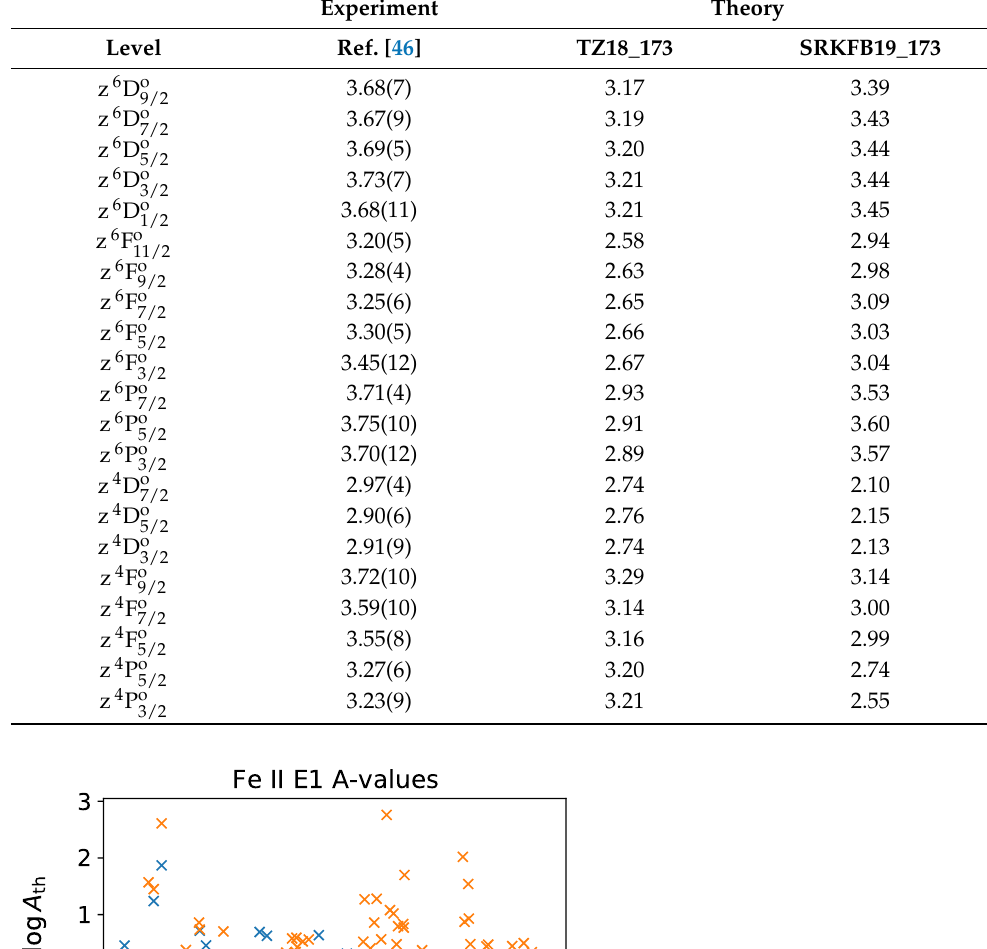
Table 14. Comparison of experimental lifetimes (in ns) of the 3d 6 ( 5 D ) 4p levels of Fe II with those derived from A -values listed in the revised PyNeb atom datasets. The error of the least significant figure of the observed lifetime is indicated in brackets.